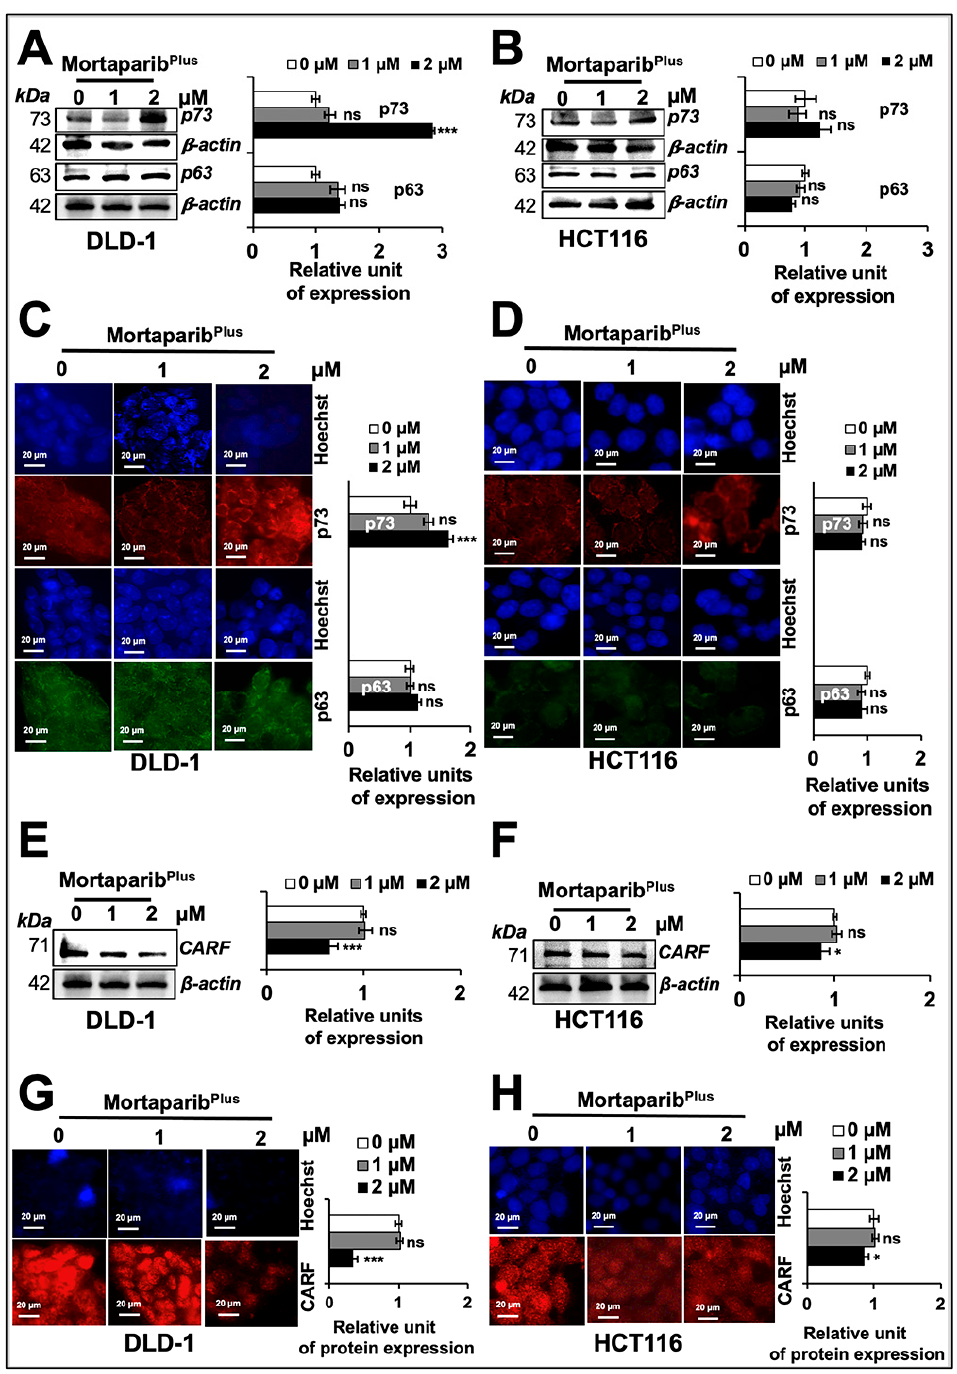
Figure 6. Mortaparib Plus activates p21 WAF1 in a p53-independent manner. Control and 24 h Mortaprib Plus -treated cells were analysed for the levels of p73 and p63 proteins by Western blotting ( A , B ) and immuno-cytochemistry ( C , D ). There were no significant changes in p63 protein levels between control and Mortaparib Plus -treated DLD1 and HCT116 cells. p73 protein levels showed an increase in Mortaparib Plus -treated DLD1 cells; but not in Mortaparib Plus -treated HCT116 cells. p63 and CARF in DLD-1 cell lysates were detected in the same blot (therefore, the same β -actin band was used for loading control). The collaborator of p14 ARF (CARF) protein levels in control and 24 h Mortaparib Plus -treated cells were analysed by Western blotting ( E , F ) and immuno-cytochemistry ( G , H ). CARF protein was down-regulated in Mortaparib Plus -treated DLD1 and HCT116 cells. The quantified data represents mean ± SD obtained from three independent biological replicates; p -values were calculated using unpaired Student’s t -test. * < 0.05 and *** < 0.001 represent significant, very significant and very very significant, respectively. Scale bar in C and D equals 20 µ